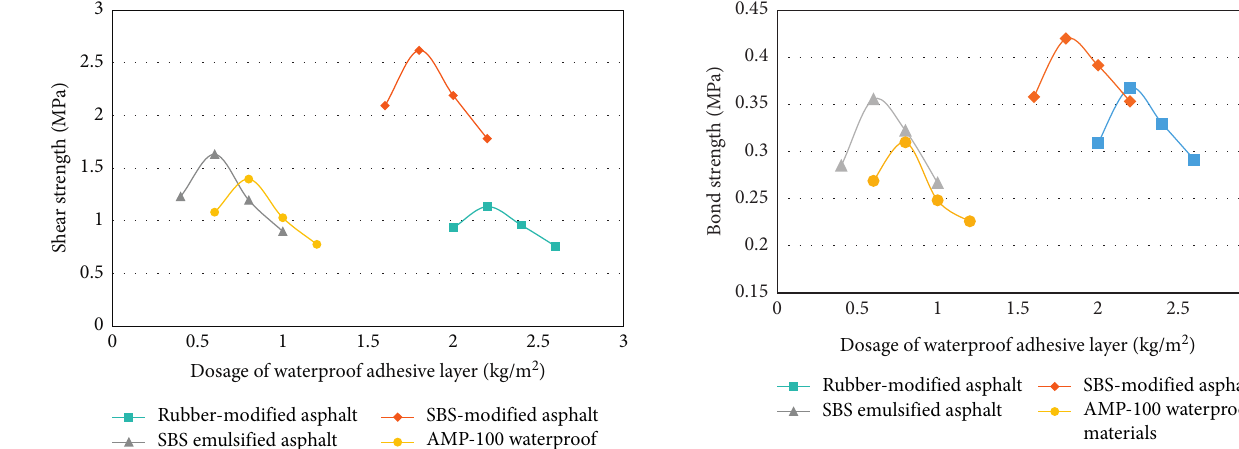
Figure 5: Bond strength of four types of waterproof adhesive layers with different